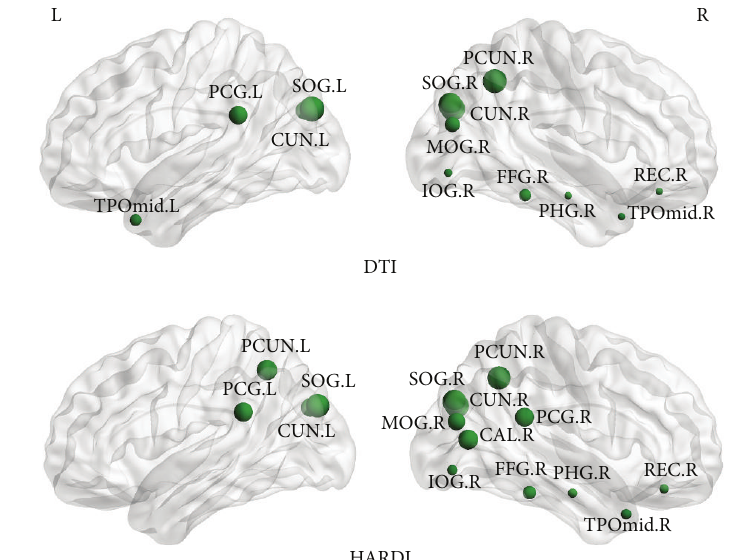
Figure 5: ROIs that have the reduced nodal efficiency in the AD group compared to the NC group ( 𝑝 < 0.05 ), given by the DTI and HARDI methods, respectively. Each sphere represents the center of an ROI and its size is proportional to the nodal efficiency. Refer to Table 2 for the label of each